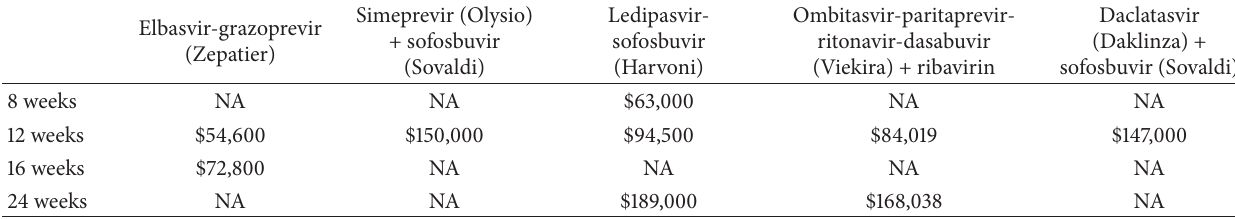
Table 2: Cost of guideline recommended therapies for HCV genotype 1a